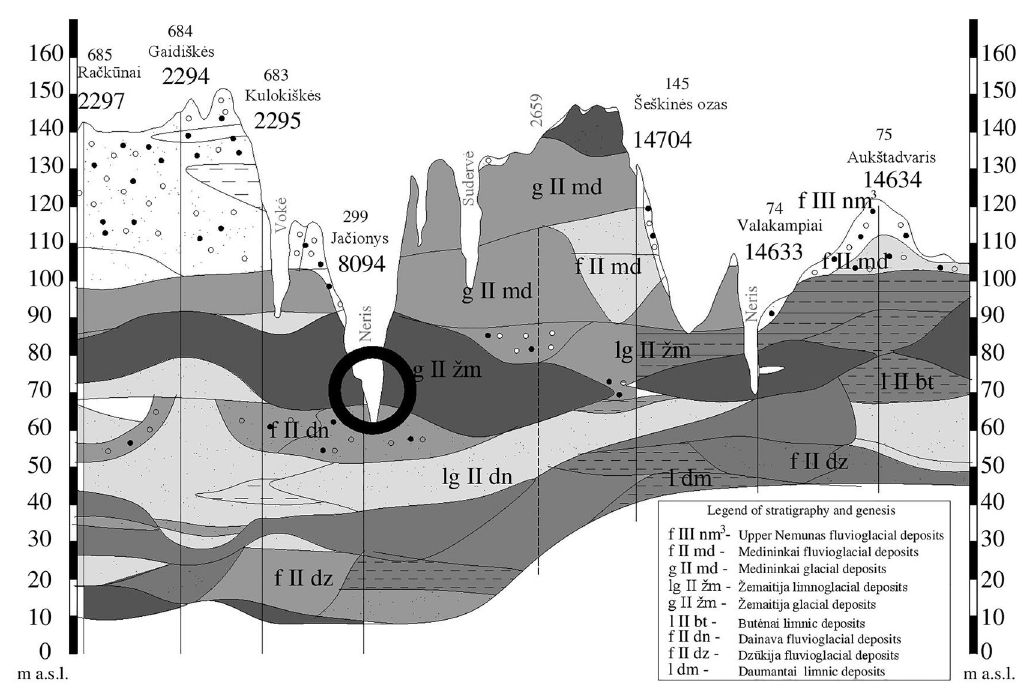
Fig. 2. Geological cross section of the study site.